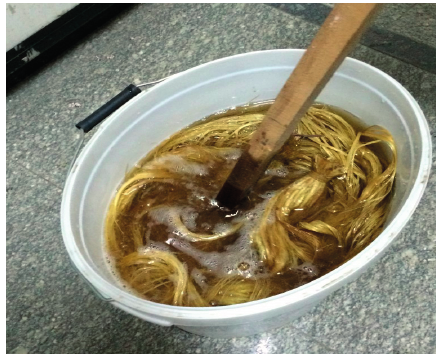
Figure 2. Submerging banana fibers in NaOH solution.